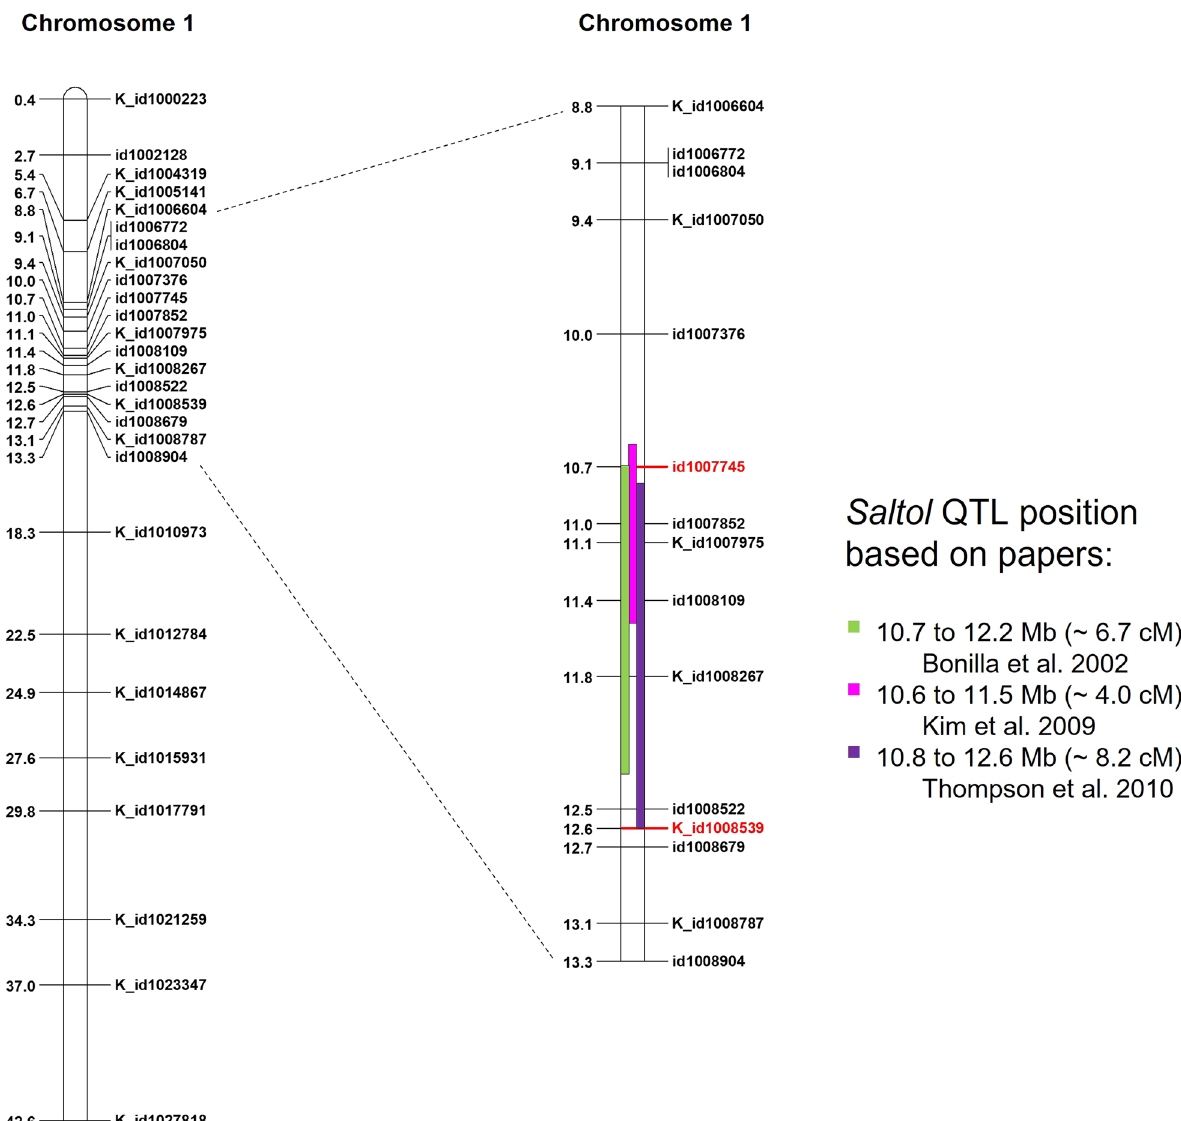
Fig. 2 Physical position on the Nipponbare genome (Os-Nipponbare-Reference-IRGSP-1.0) of the 27 KASP markers for chromosome 1 utilized for the background selection (left image). Position of the markers is reported with respect to the position of the Saltol QTL in the indicated mapping studies; markers used for the foreground selection are highlighted in red (right